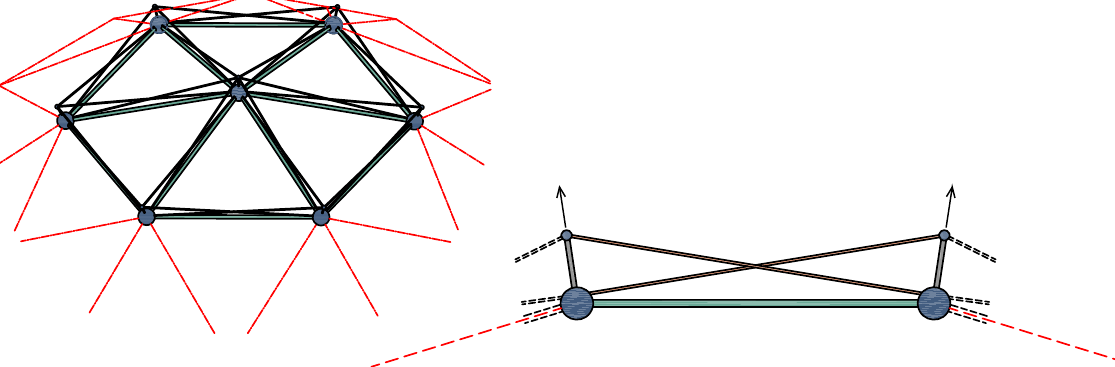
Fig. 5 Scheme of the reduced model adopted within the optimization routine: main truss in green, low-stiffness secondary trusses in orange, rigid truss in grey. The well-known objective of pre-stress is to stiff the shell and to enhance the efficiency of the structure. Additionally, as in this case, pre-stress is used to eliminate or to significantly reduce the overall tension. Technically, once the shell is assembled the pre-stress is conferred by post-tensioning via cables. Sliding cables are point fixed at the nodes, so that their configuration results in a 3D polygonal line described by subsequent glass